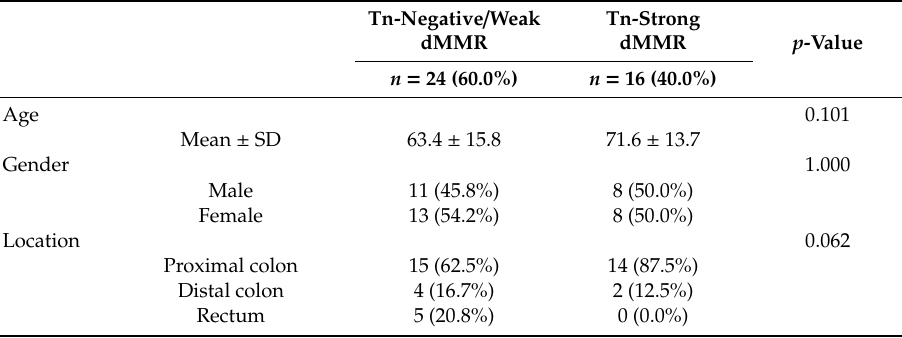
Table 2. Clinicopathological characteristics of patients with mismatch-repair deficient colorectal cancer according to Tn antigen